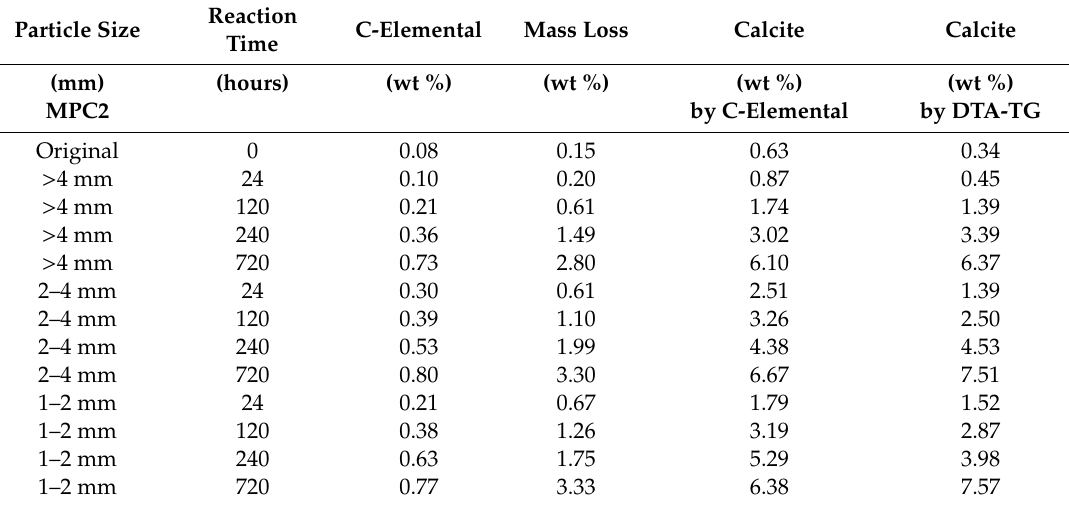
Table 3. Carbon elemental content, mass loss by di ff erential thermal and thermogravimetric analysis (DTA-TG), and calcite content calculated by both techniques.